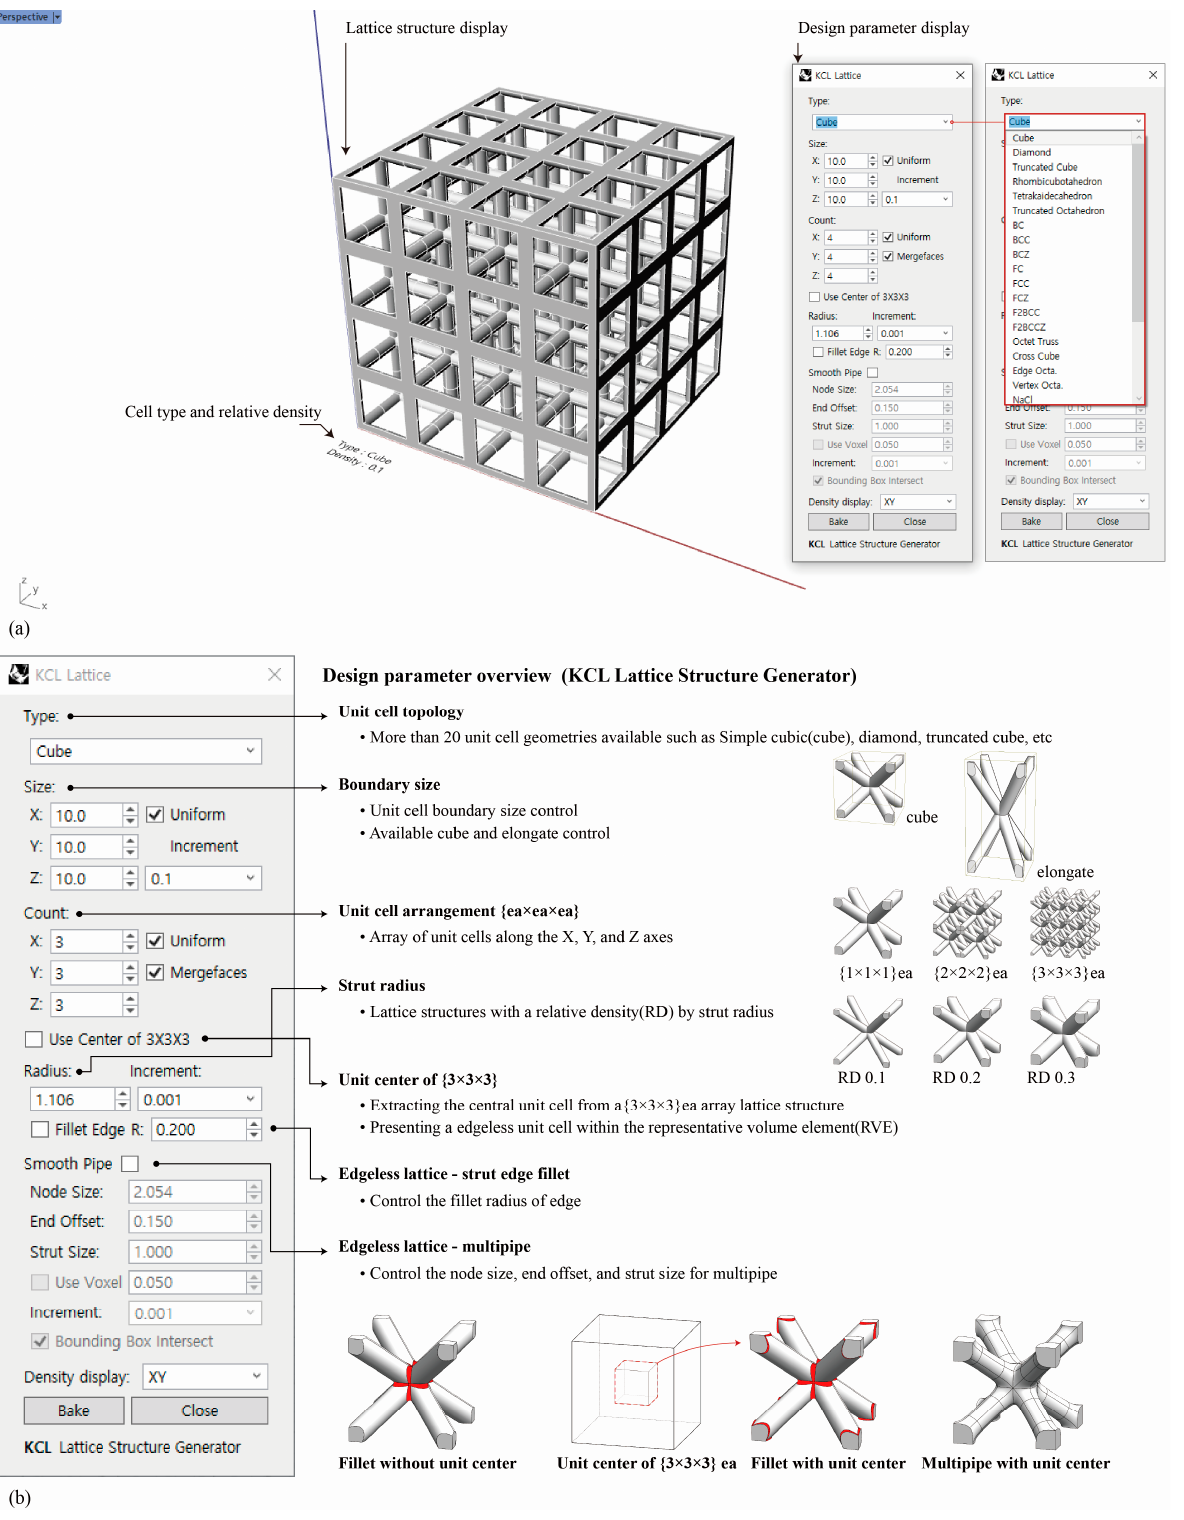
Figure 4. Screenshots of the KCL lattice structure generator plugin for Rhinoceros: ( a ) graphical user interface; ( b ) design parameters.